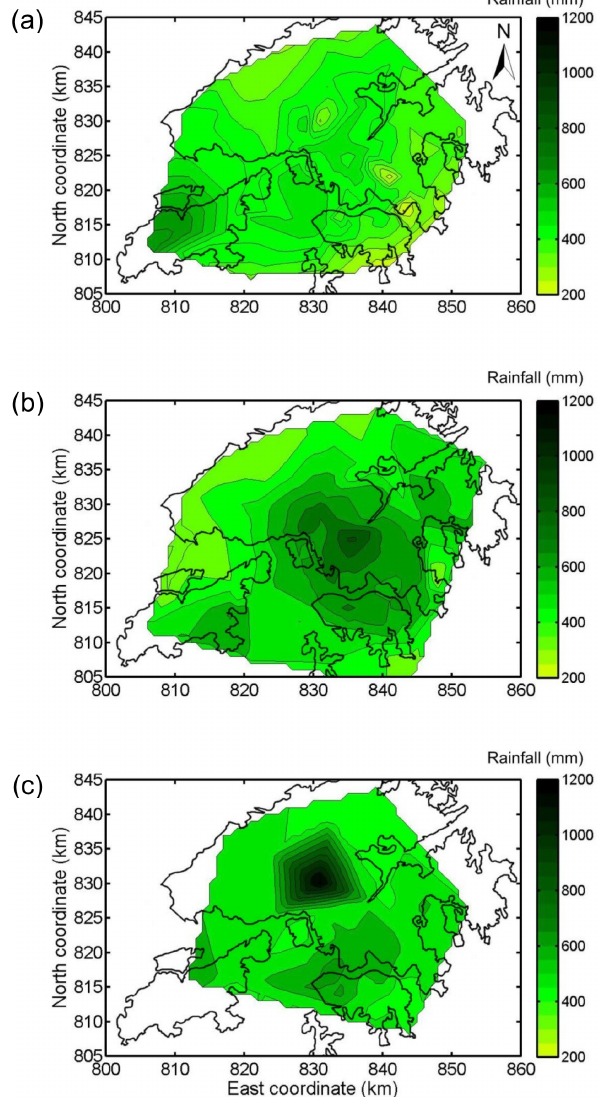
Figure 7. Spatial distribution of the total rainfall amount: (a) the 5–7 June 2008 storm; (b) the 17–21 August 2005 storm; (c)